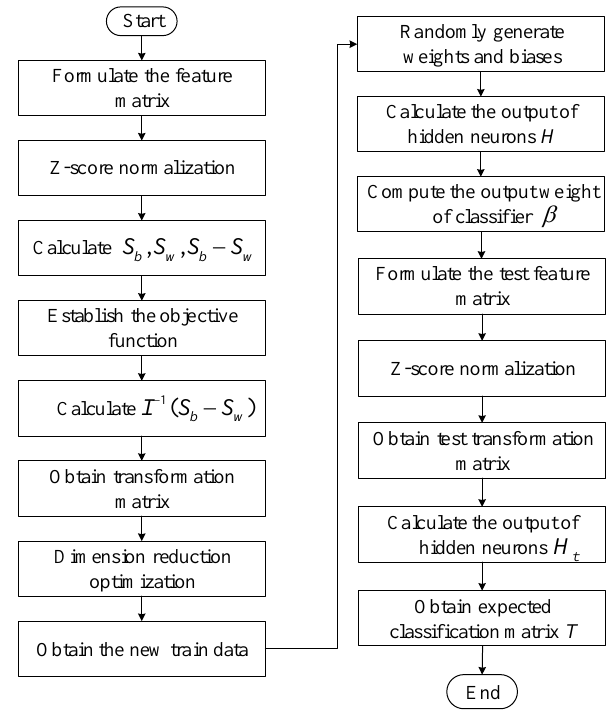
Figure 5. The flow chart of